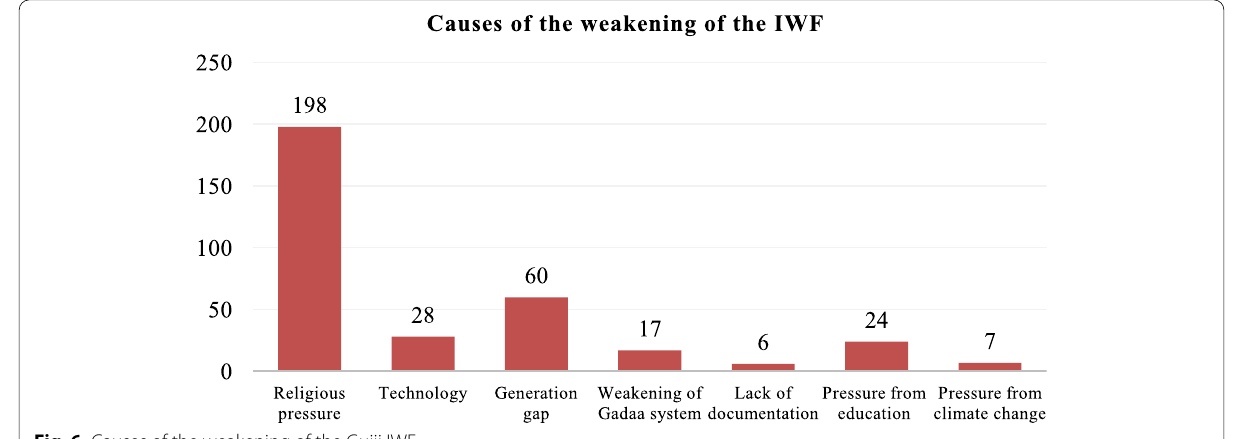
Fig. 6 Causes of the weakening of the Gujii